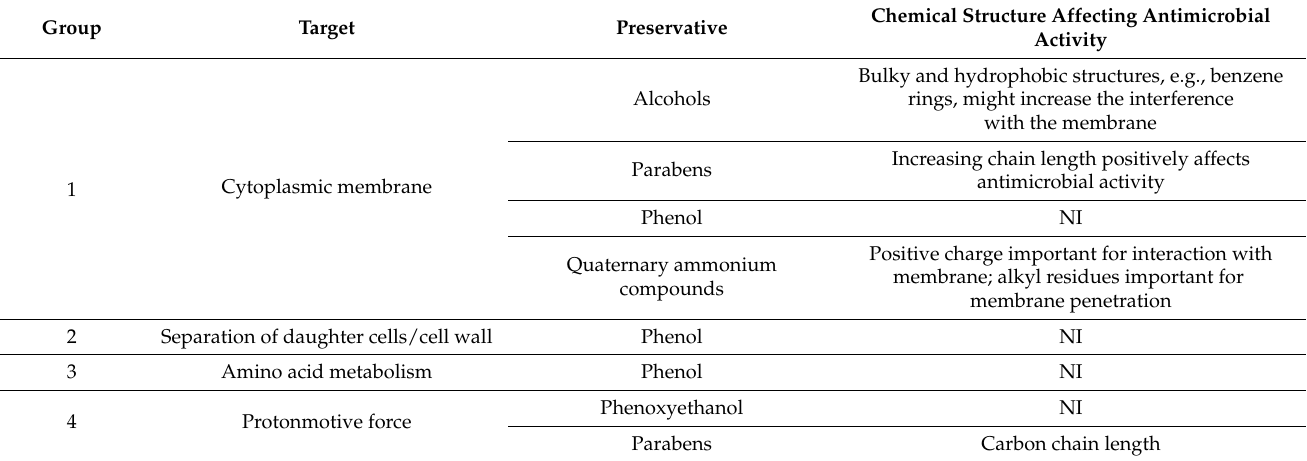
Table 2. Classification of preservatives based on their mechanisms and activity sites in microbial cells. Information about the chemical structure important for the antimicrobial activity is added if known. Abbreviation: NI= no